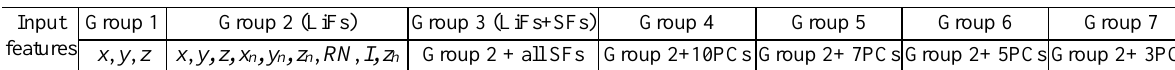
Figure 1: Workflow of the proposed algorithm.